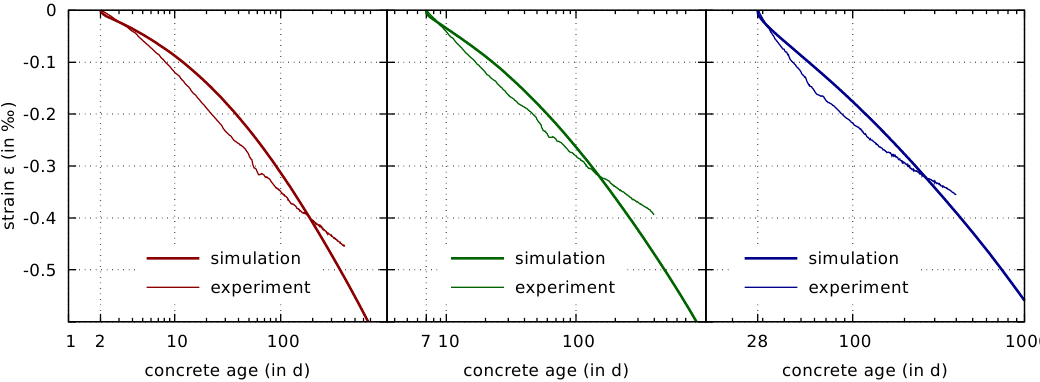
Figure 10. Comparison of measured [7] and computed evolutions of shrinkage strains of drying cylindrical specimens with drying started at concrete ages of 2 days ( left ), 7 days ( center ), and 28 days ( right